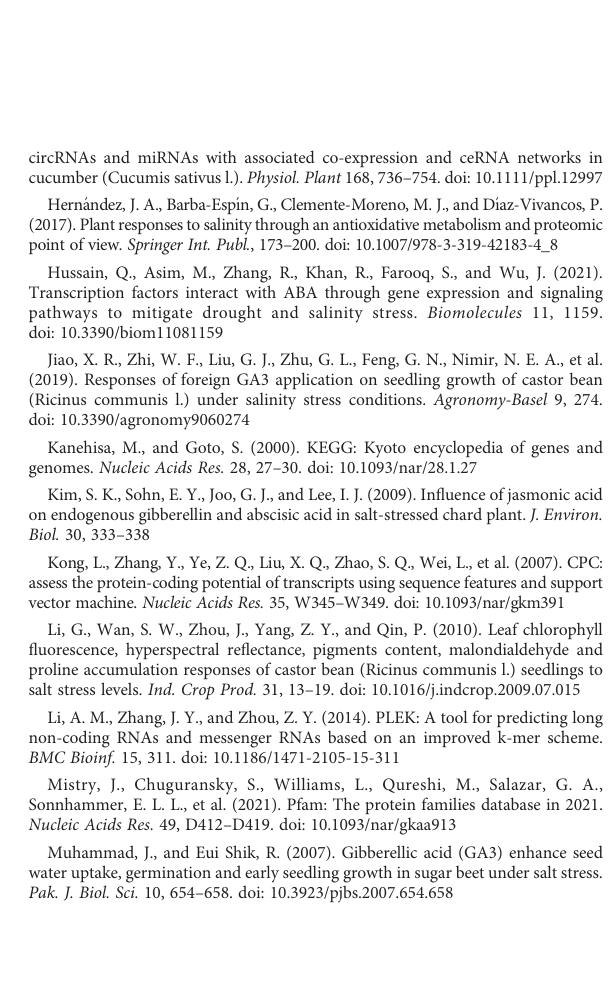
and control (GL_B) sorghum ( “ Jitian 3 ” ). SUPPLEMENTARY TABLE 6 KEGG network enrichment analysis of the differentially expressed (DE)-lncRNAs target genes in sorghum ( “ Jitian 3 ” ). SUPPLEMENTARY TABLE 7 A list of differentially expressed (DE)-circRNAs in the GA 3 -exposed (GL_A) and control (GL_B) sorghum ( “ Jitian 3 ” ). SUPPLEMENTARY TABLE 8 A list of differentially expressed (DE)-miRNAs in the GA 3 -exposed (GL_A) and control (GL_B) sorghum ( “ Jitian 3 ” ). SUPPLEMENTARY TABLE 9 KEGG network enrichment analysis of the differentially expressed (DE)-miRNAs target genes in sorghum ( “ Jitian 3 ”